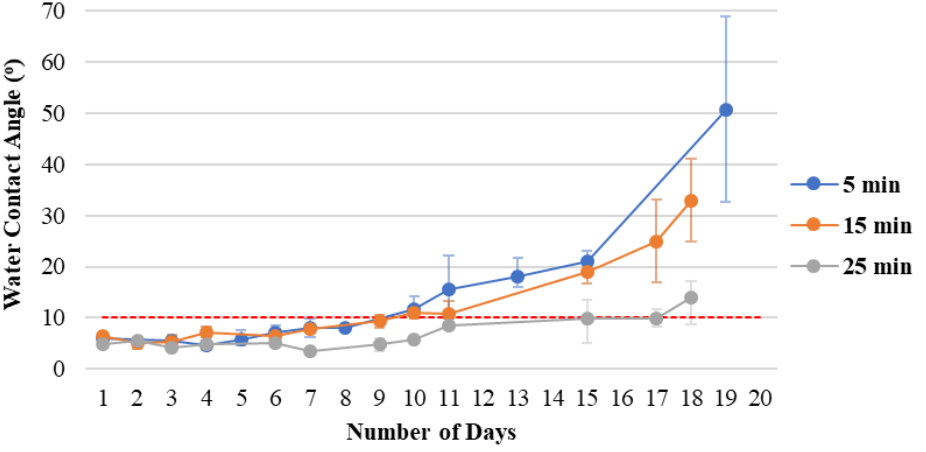
Figure 5. Hydrophilicity persistence of polymer films on untreated PC substrates with different coating times.